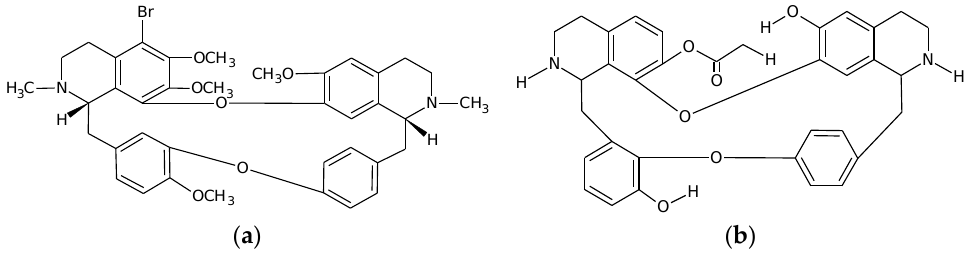
Figure 2. Structures of 5-bromotetrandrine and W6. ( a ) Bromotetrandrine (11S,31S)-35-bromo-16,36,37,54-tetramethoxy-12,32-dimethyl-11,12,13,14,31,32,33,34-octahydro-2,6-dioxa-1(7,1),3(8,1)-diisoquinolina-5(1,3),7(1,4)-dibenzenacyclooctaphane [53]; ( b ) W6 [54].